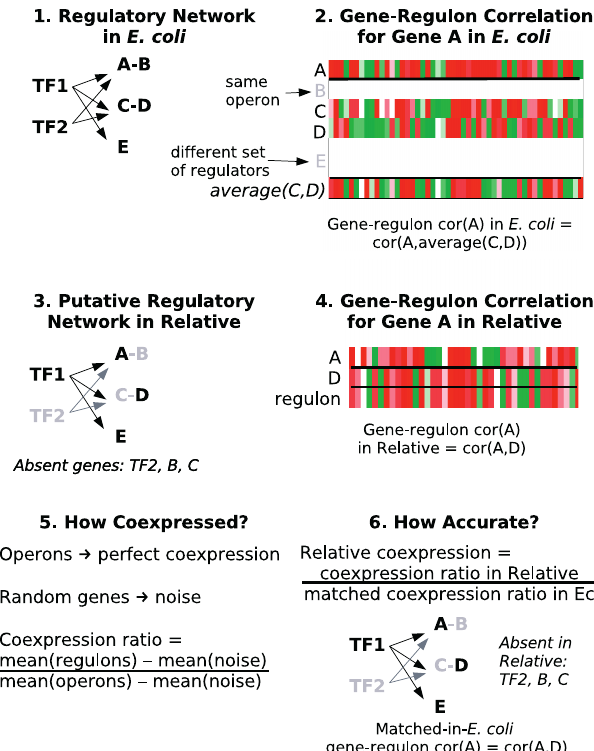
Figure 4. Using Patterns of Gene Expression To Test Putative Regulation in Relatives of E. coli (Steps 1–4) We use ‘‘ gene–regulon ’’ correlations to see if the regulation agrees with microarray data, both in E. coli and in its relatives. To compute gene–regulon correlations, we first average the expression pattern (the log-ratios) for other genes that are not in the same operon and are regulated by the same set of TFs. The rationale for using gene– regulon correlations instead of gene–gene correlations is explained in Methods. If the gene–regulon correlation is high in E. coli and low in the relative, then the regulation may have changed. (Step 5) To correct for the varying quality and quantity of the microarray data for the different species, we use operons as a positive control and random pairs of genes as a negative control. Thus, the ‘‘ coexpression ratio ’’ should depend on the accuracy of the predictions, and not on the quality of the microarray data. (Step 6) To quantify how the predictions compare with regulation in E. coli , we use the ‘‘ relative coexpression. ’’ To control for the absence of genes in the related organism, we compare the coexpression ratio in the related organism to a ‘‘ matched ’’ coexpression ratio that uses only E. coli genes that have BBHs in that